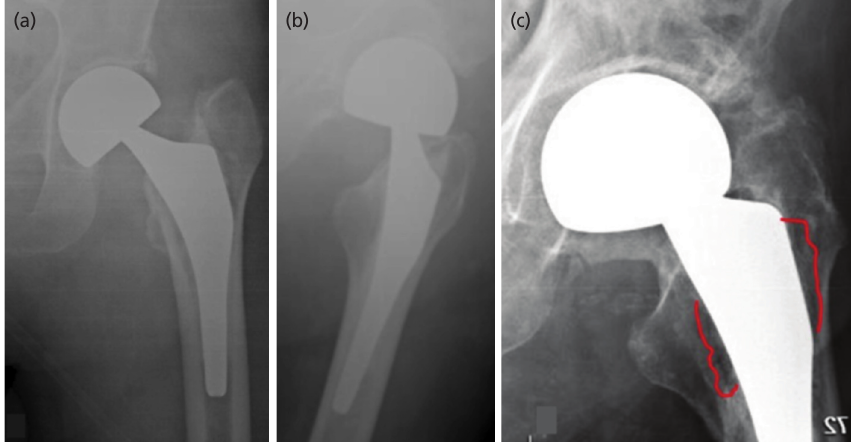
Fig. 2: (a) Left hip radiographic anteroposterior view after hemiarthroplasty through anterior approach. (b) Post-operative lateral view. (c) Area of bone resorption (red line) and heterotopic ossification 12 months after